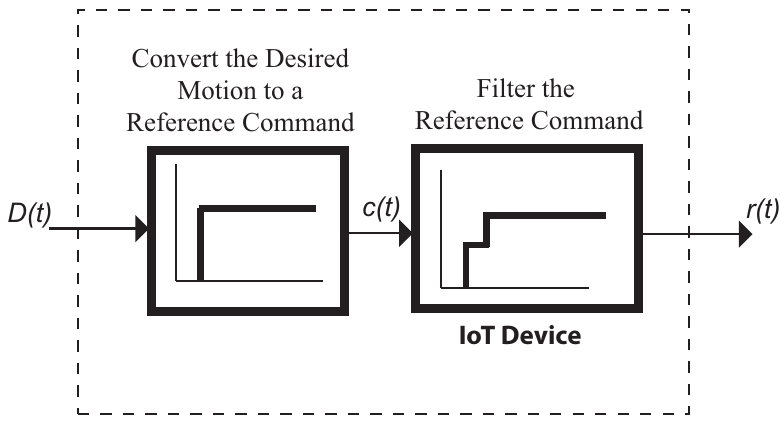
Figure 18. Command generator for real-time command shaping.